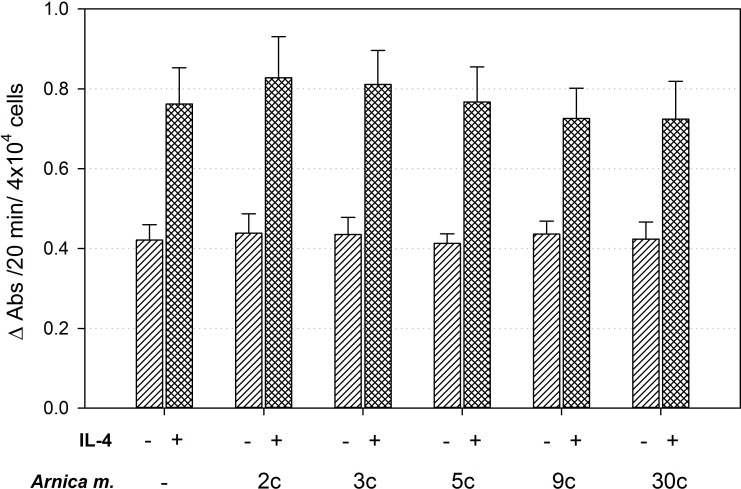
Cell viability of macrophages.THP-1 macrophages in the resting state (diagonal bars) or after differentiation with IL-4 (crossed bars) were cultivated for 24 hours in the presence of Arnica m. at various dilutions or Control solvent. The histograms report mean values ± SE of 6 separate wells of a typical experiment. There are no significant differences between any Arnica m. dilution and Control (p>0.05)